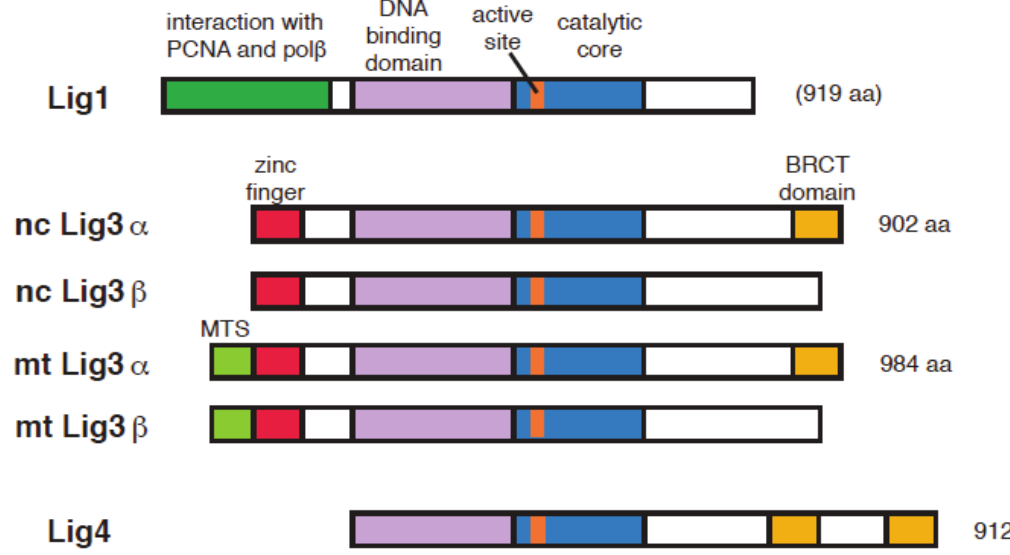
Figure 1. Domain structure of vertebrate DNA ligases. Nc: nuclear; mt: